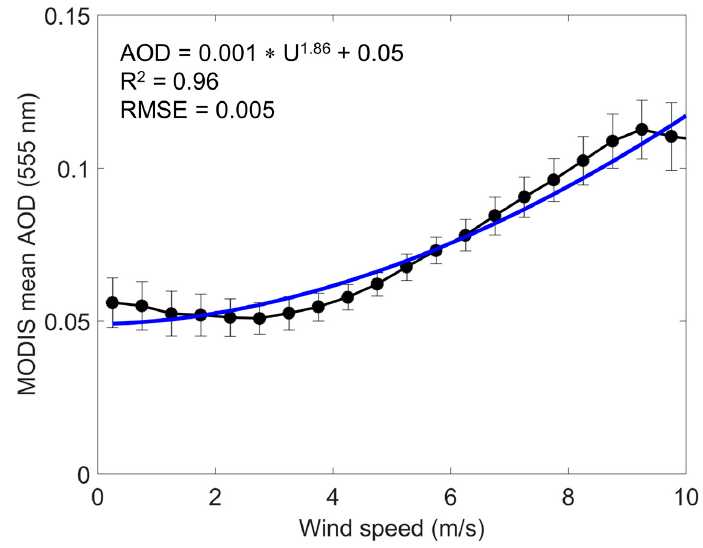
Figure 9. MODIS-adjusted mean AOD (black solid circle) with corresponding one standard deviation, averaged with respect to the median annual curves obtained for summer, fall and winter in Figure 4. The blue solid line is a power-law fit of the mean AOD values. Atmosphere 2018 , 9 , x FOR PEER REVIEW